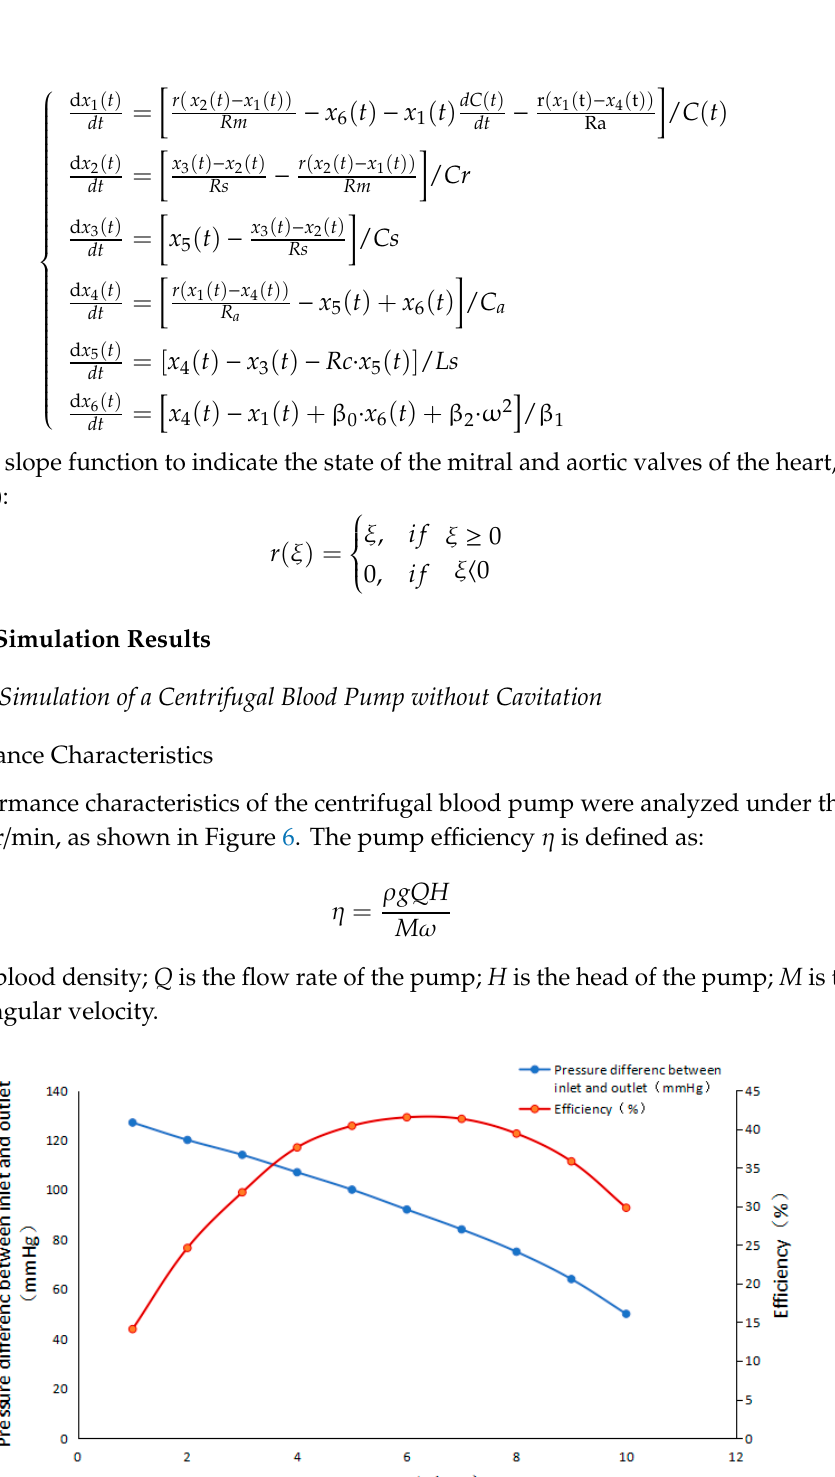
( c ) Figure 7. Pressure distribution of blades under the different flow rates of 3330 r/min: ( a ) 4 L/min; ( b ) 5 L/min; ( c ) 6 L/min. Figure 8 is the pressure distribution diagram of the impeller blade surface at different speeds of the pump, and the flow rate is 5 L/min. It can be seen from Figure 8 that as the speed increases, the pressure on the blade surface close to the leading edge of the blade decreases sharply. This is because the increase of rotating speed will increase the pump head. According to the Equation (6), the higher the rotating speed, the greater the negative pressure at the pump inlet. Cavitation will occur when the negative pressure at the pump inlet is lower than the critical cavitation pressure. 2